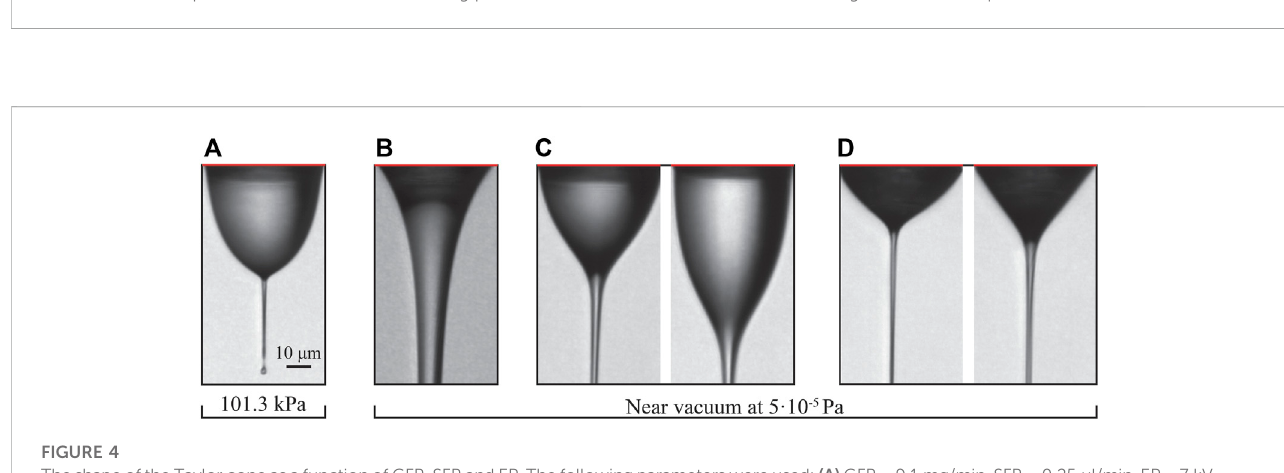
FIGURE 3 Automated jet-shape-processing method pipeline is shown on the top of the image. Detail (A) shows the raw image of the jet and its binarized form in detail (B) . The result from the post processing is shown in detail (C) , where the dotted line represents the diameter measurement and the full line represents thecalculatedvelocity.Theaveragedimageofthewholestack isshown indetail (D) .Thelocationoftheaveragebreakup isenlargedontheright.The redline marks the nozzle tip location all details. The following parameters are used for this case: GFR = 0.1 mg/min, SFR = 0.5 μ l/min, EP = 5 kV, L = 0.405.